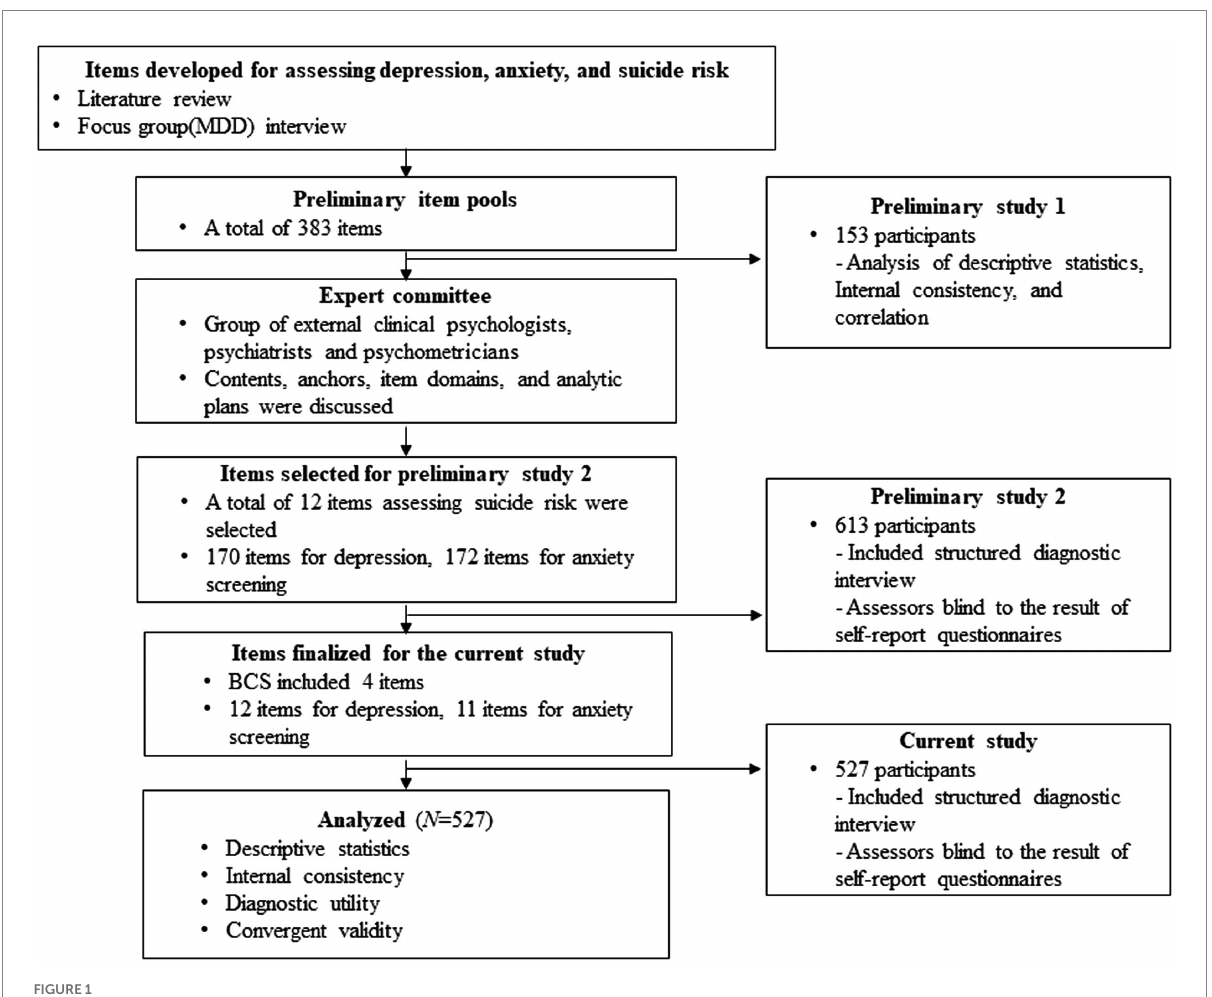
FIGURE 1 Development procedure.